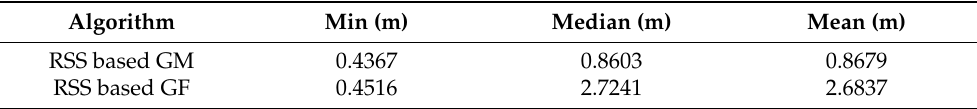
Table 1. Statistical characteristics of root-mean-square-errors (RMSE).